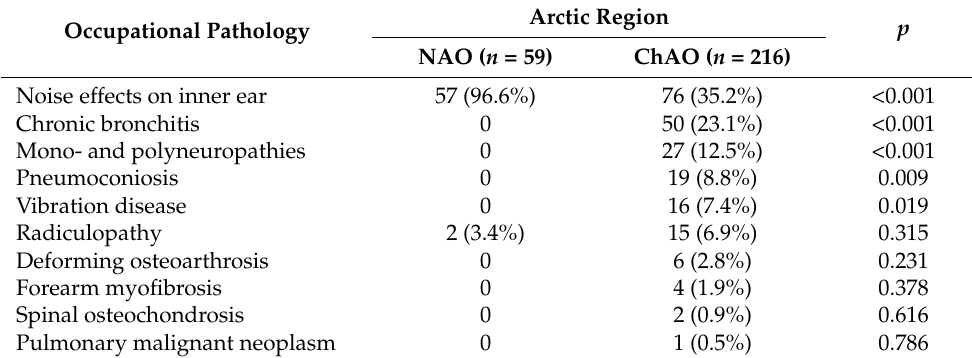
Table 5. Clinical characteristics of occupational pathology (cases and